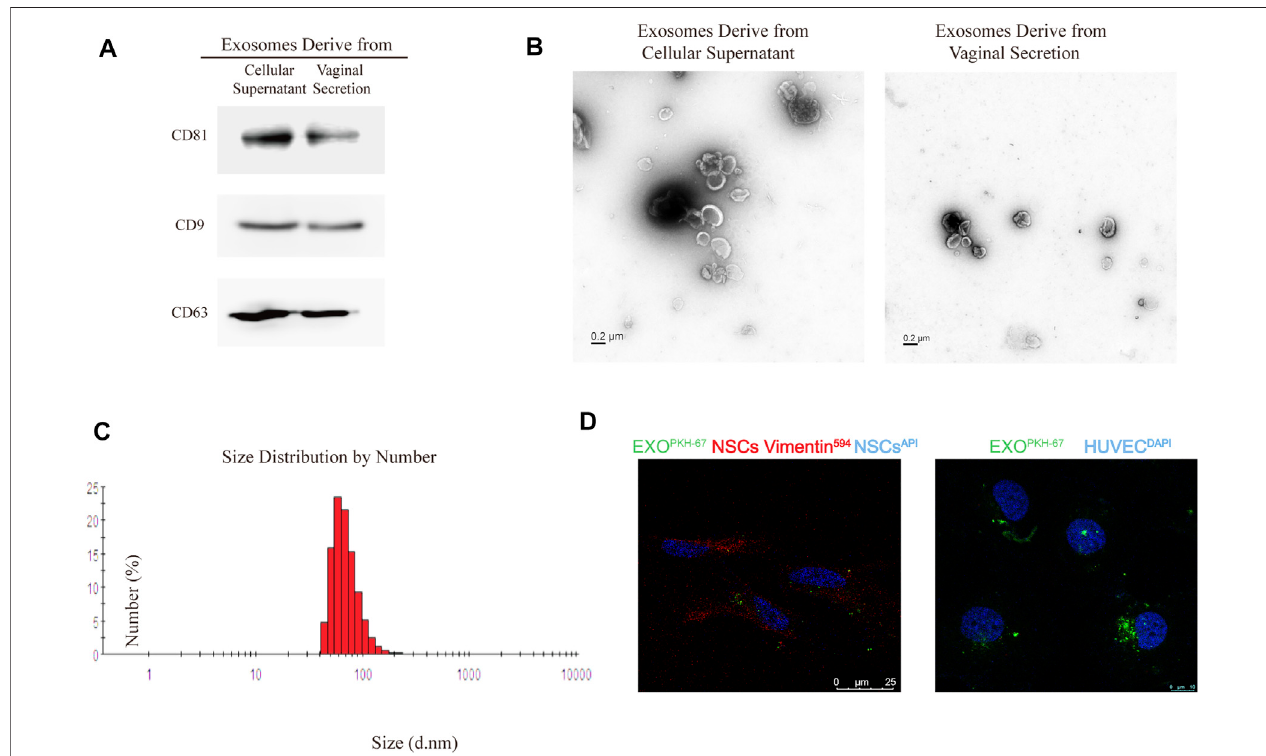
FIGURE 1 | Identi fi cation of exosome characteristics. (A) Western blot analysis of exosomal marker CD63, CD81, and CD9 in exosomes from primary cellular supernatantand vaginalsecretion. CD9did not express inexosomes derivedfrom vaginalsecretion. (B) Transmission electron microscope (TEM)ofexosomes. (C) The average size of exosomes is 95.5 nm. (D) . PKH67 staining of exosomes internalization by Normal endometrial stromal cells (NSCs) and HUVECs were observed by the confocal microscope, anti-vimentin was the NSCs marker, HUVECs nuclei labeled with